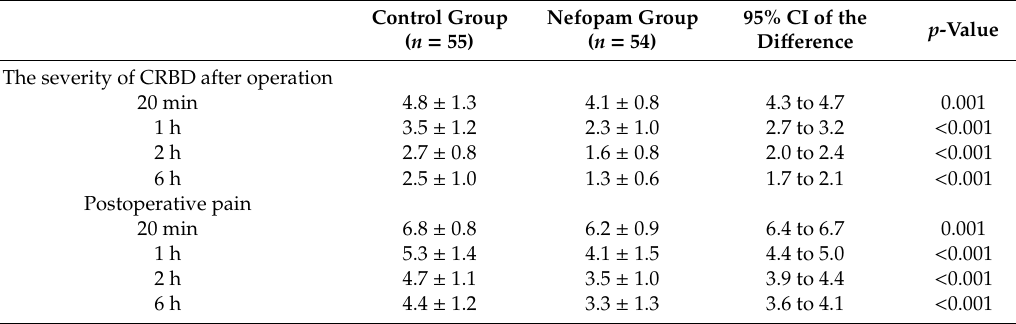
Table 2. The severity of CRBD and postoperative pain.